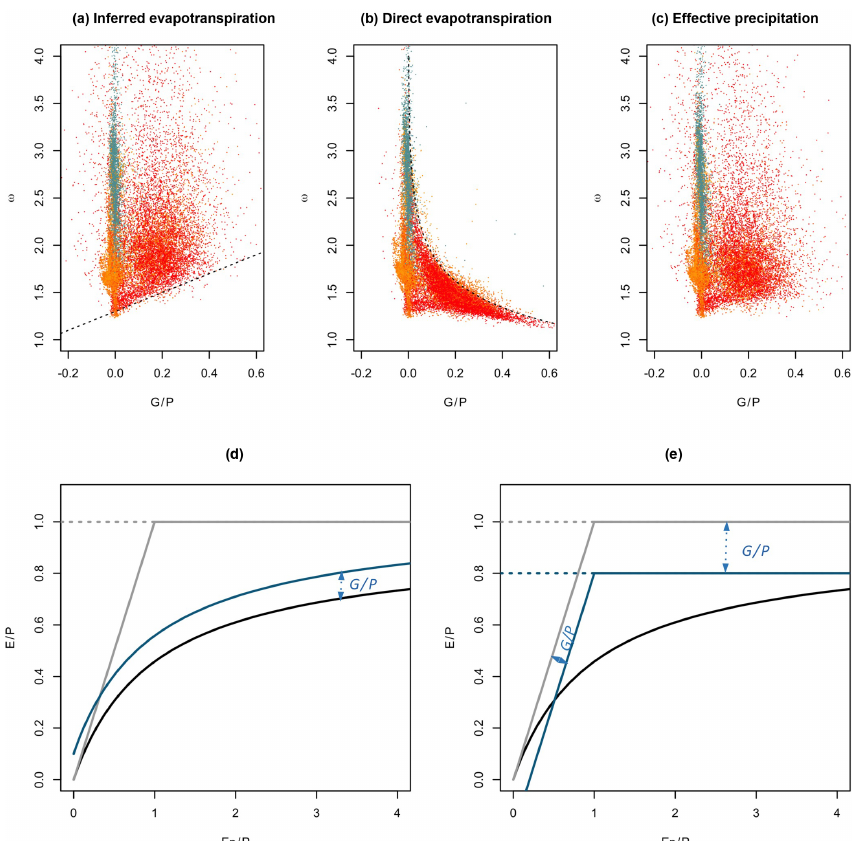
Figure 7. Comparison of shape parameters to groundwater contribution ratios for the three approaches in every watershed (a–c) . Points are colored by aridity as shown in Fig. 3a. A dashed line with a slope of 1 is included on (a) for reference. The dashed line on (b) shows the relationship between the shape parameter and groundwater contribution fraction for an example aridity value of 6 in the limiting case where outflow is zero. The conceptual figures below illustrate the impact of a positive groundwater contribution (i.e., a net flux from the surface to the subsurface) for (d) the inferred evapotranspiration and (e) direct evapotranspiration